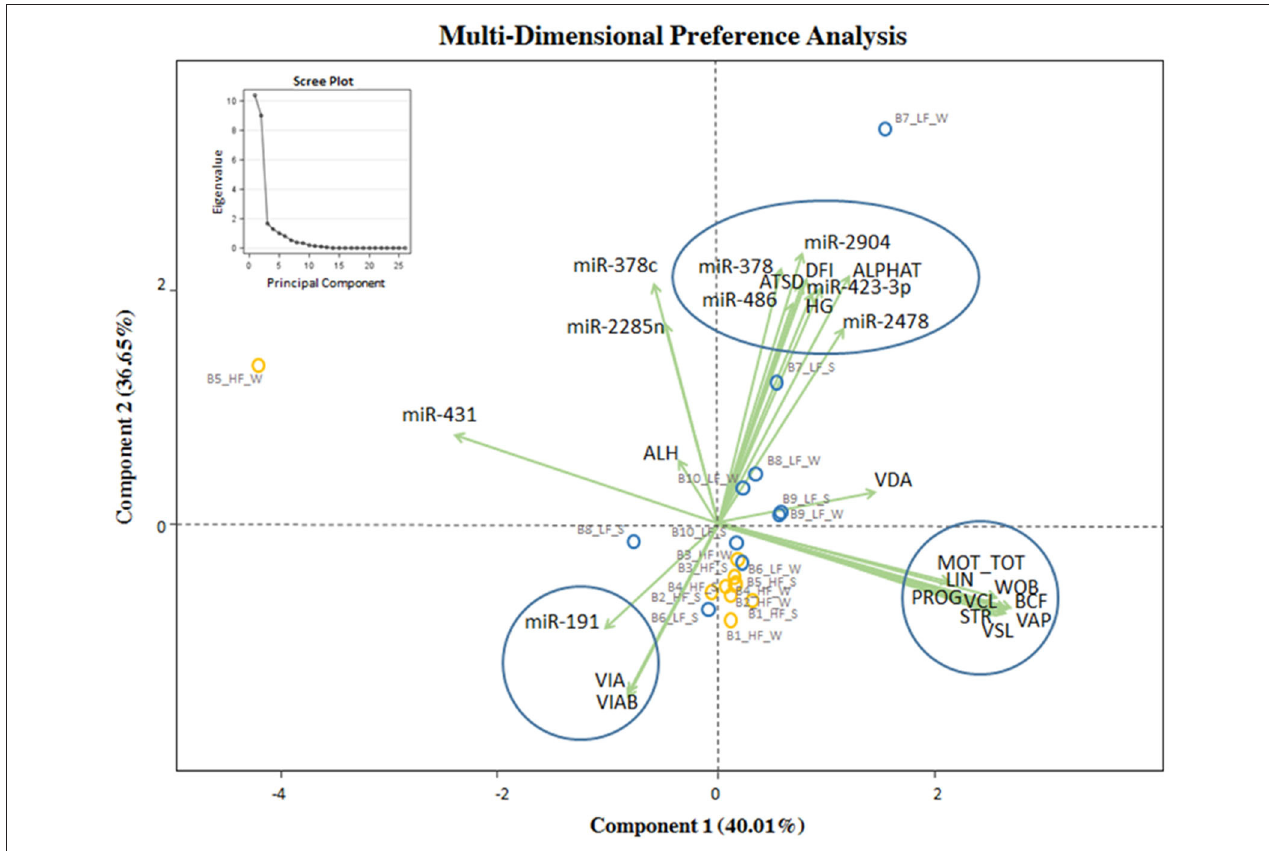
FIGURE 4 | MDPREF analysis biplot based on the combination of in vitro sperm quality parameters, miRNA, and observed field fertility. The dots indicate the exact position of HF and LF bulls (yellow and blue, respectively) between the two components. The ellipse and circles represent the clustering relative to in vitro sperm quality parameters and miRNA: sperm motility and kinetics parameters (MOT TOT, MOT PROG, VCL, VAP, VSL, LIN, WOB, BCF, STR, on the right); DNA integrity and miRNA indicators (Alpha-T, ATSD, %DFI, %HG in the upper part); viability and acrosomal status and miRNA indicators (VIA, VIAB, in the lower part). The scree plot, in the upper left corner of the figure, was reported to explore the optimal groups of the